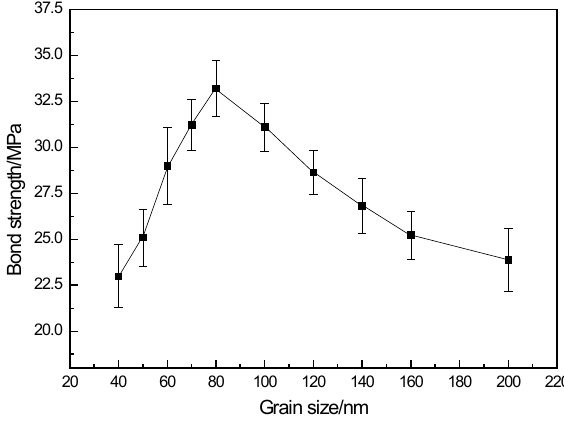
Figure 7: I nfluence of nanocrystalline on the bonding strength between carbon fiber and nickel matrix.